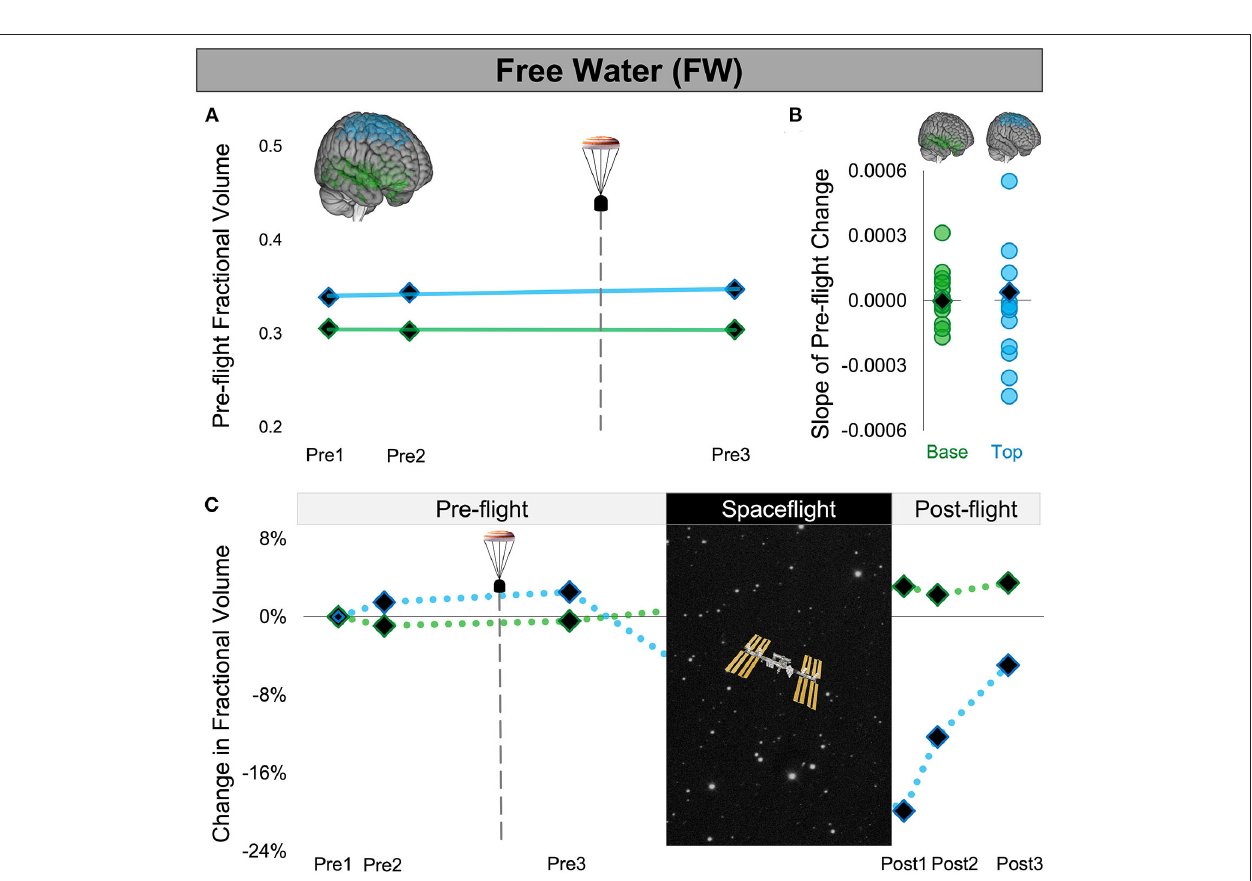
FIGURE 3 | Free Water Changes Following Launch Abort and Spaceflight. (A) CAL’s pre-flight changes in FW fractional volume at the top (blue) and base (green) of the cerebrum. The solid trend lines indicate the slopes of pre-flight ventricular volume changes. The aborted launch is indicated by the gray dashed line and capsule icon. (B) Slopes of CAL’s pre-flight FW fractional volume changes (black diamond) compared to the slopes of pre-flight FW fractional volume changes of 12 ground-based control astronauts (circles). (C) CAL’s FW fractional volume changes from before to after a 6-month expedition on the ISS. Volume changes are reflected as percent volume change relative to baseline (Pre1). CAL, Crewmember who experienced the Aborted Launch; FW, free water; ISS, International Space